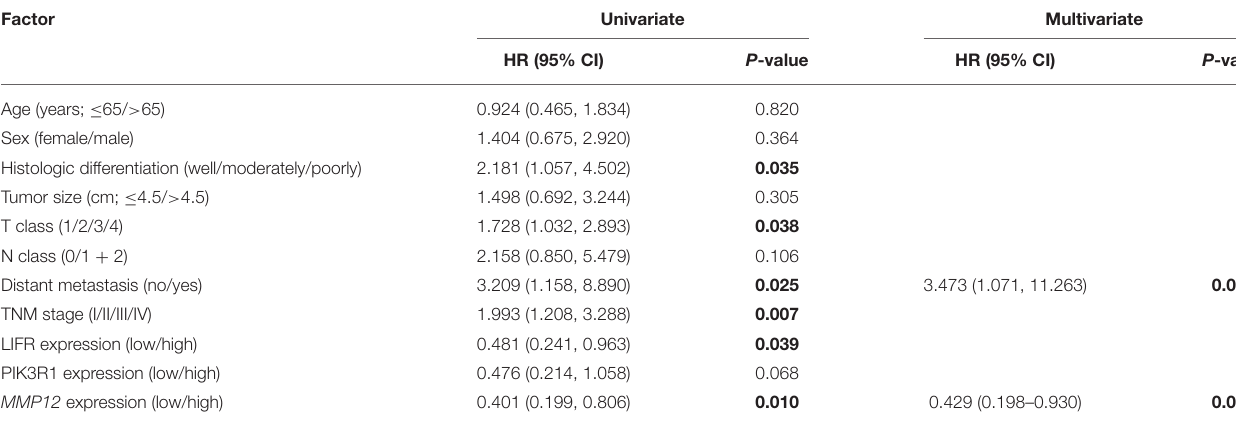
TABLE 3 | Univariate and multivariate Cox regression analyses for overall survival in GBC. Factor Univariate